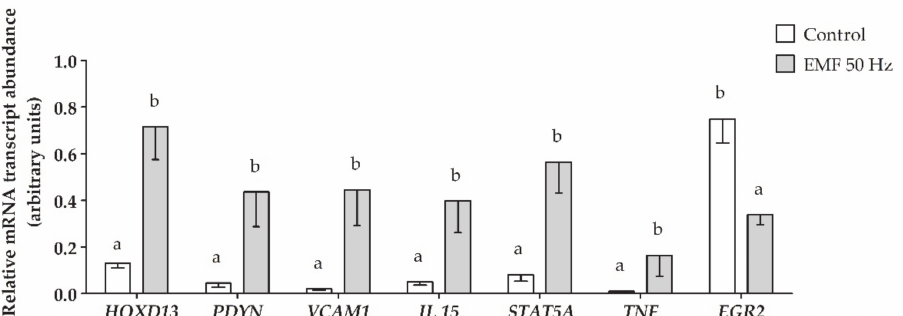
Figure 5. The relative mRNA expression of genes with the altered expression in porcine myometrium during the peri- implantation period, in response to the EMF treatment (50 Hz, 2 h, 8 mT). mRNA transcript abundance values are presented as men 2 − ∆∆ Ct values ± SEM. Different lower-case letters (a, b) indicate statistically significant differences in gene expression between control (no EMF) and experimental (EMF-treated)